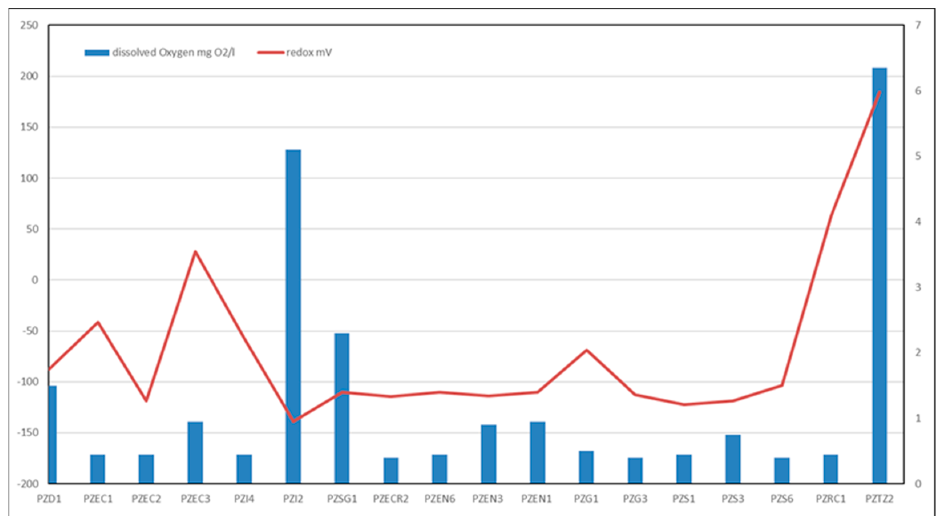
Figure 9. Graph of the O 2 Concentration–Redox Potential in the Monitoring Points (Median Values) [6].